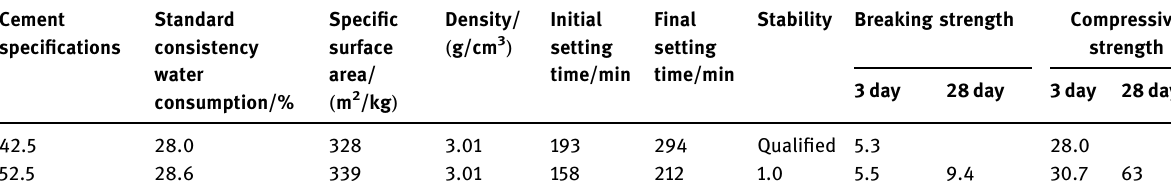
Table 1: Physical properties of cement